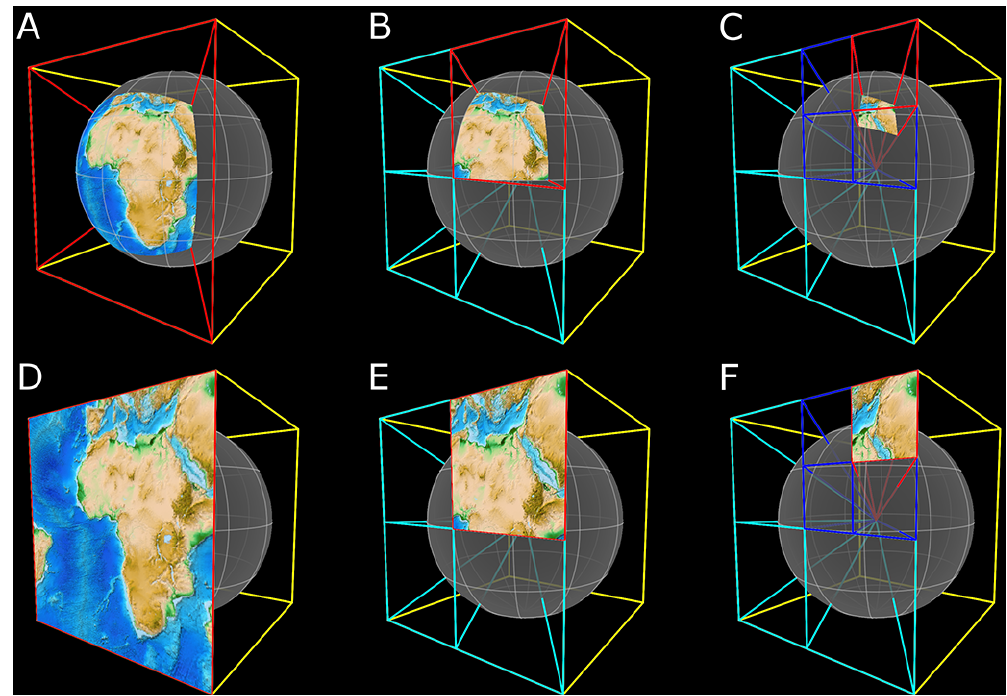
Figure 4. Quadtree partitioning of a single cube face of the ETOPO1 global raster (Amante and Eakins, 2009). The yellow wireframe represents the cube. The red wireframe represents the perspective (pyramid) frustum containing the highlighted raster tile – note that these can be off-axis pyramids (in B, C, E and F ). (A) The tile at level 0 of the quadtree covering the entire cube face. (B) The four tiles at quadtree level 1 (cyan wireframe). These are the children of the tile in (A) . (C) Four (out of sixteen) tiles at quadtree level 2 (blue wireframe). These are the children of the tile rendered in (B) . (D–F) Same as (A–C) except that the rendered tiles are radially projected onto the cube face to show the actual tile textures (square 2-D